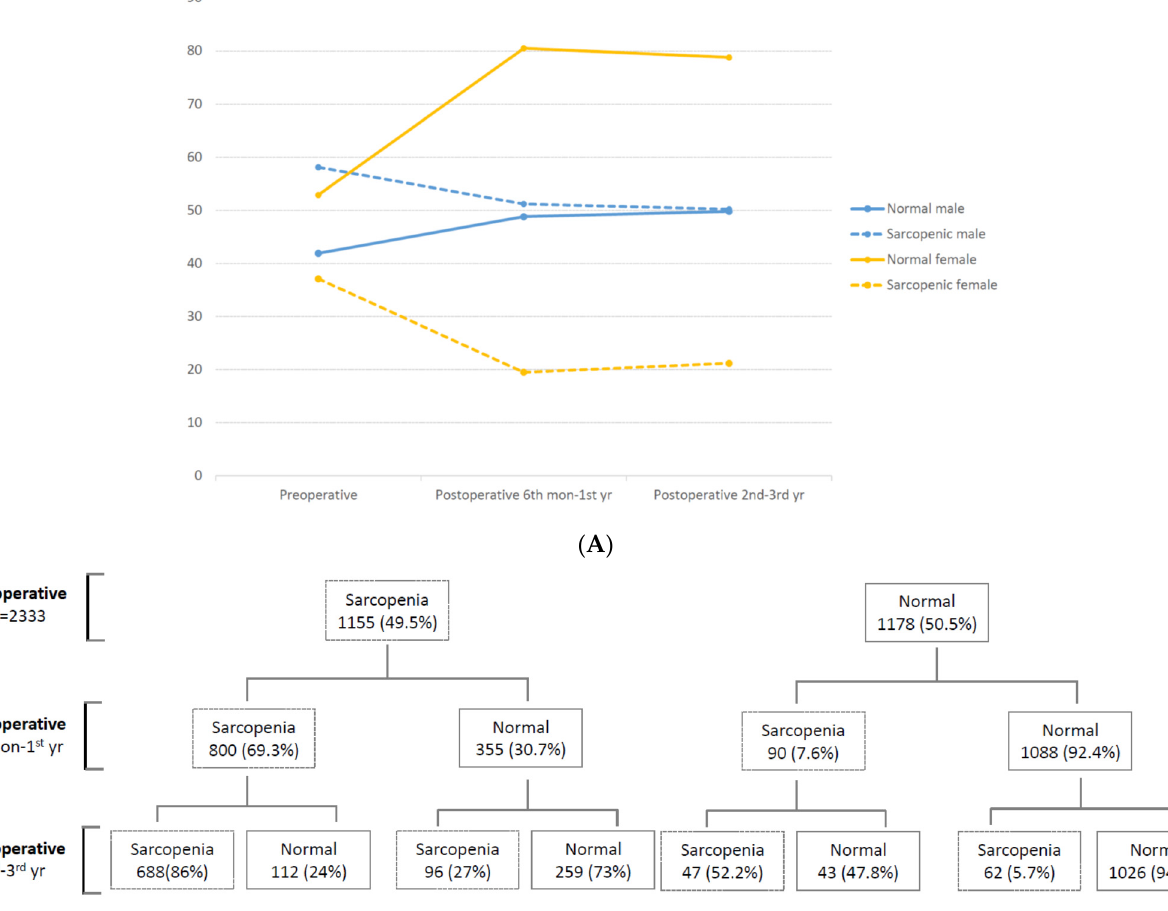
Figure 3. Proportions of sarcopenia and normal body composition during surveillance. ( A ) Changes in sarcopenic status during surveillance. ( B ) Number of patients with sarcopenia or normal status during surveillance according to sex.